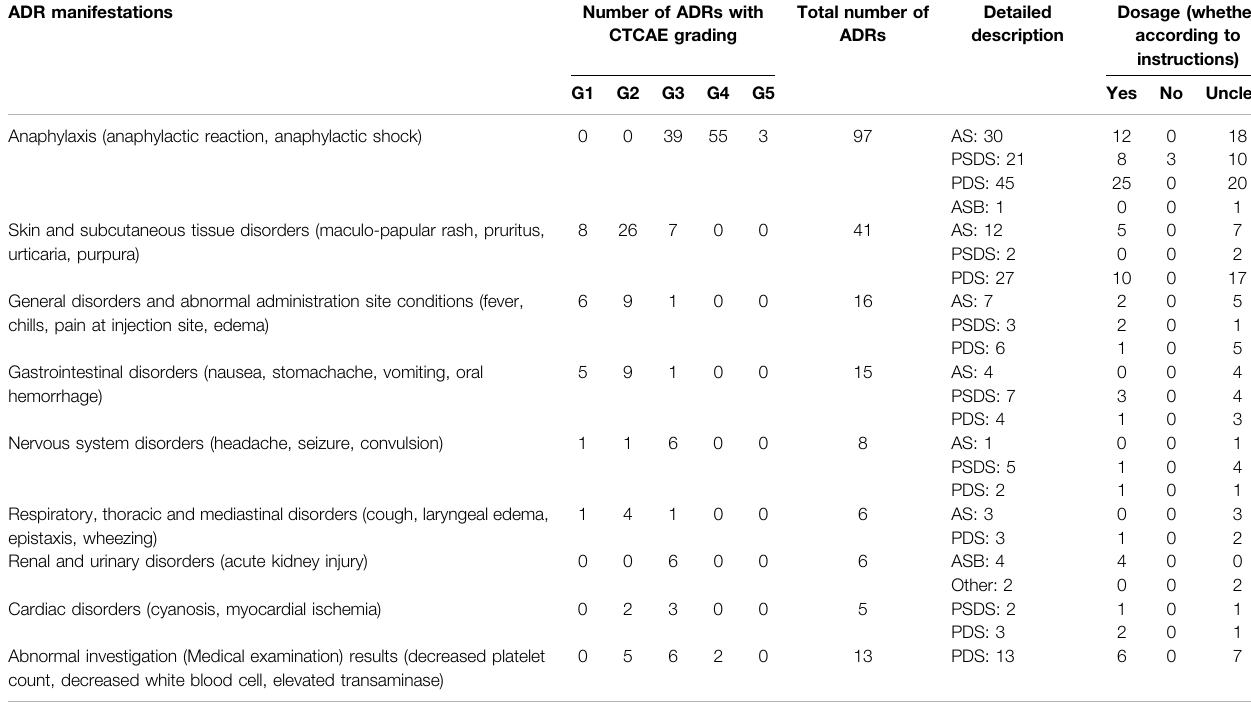
TABLE 5 | Manifestations and severity of ADRs of andrographolide derivative injections reported in the included case reports. ADR manifestations Number of ADRs with CTCAE